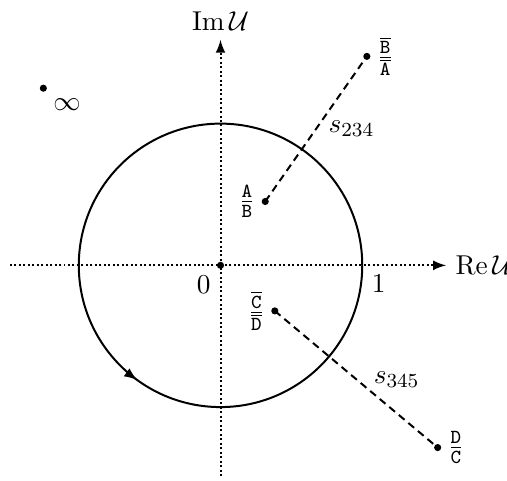
Figure 1 . Sample con(cid:12)guration of the poles of the integrand in (4.6) for the undeformed u (2 ; 2 j 4) Yangian invariant (cid:9) 6 ; 3 . Dashed lines connect pairs of poles. For each pair, exactly one pole is inside of the contour. The signs of the Mandelstam variables s 234 and s 345 determine which one. These are expressed in terms of the dual variables x i and (cid:18) i . They are de(cid:12)ned by